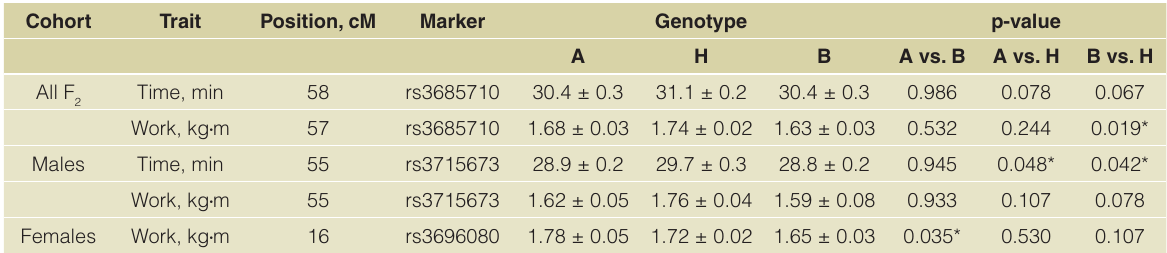
Table 3. Allelic effects for significant and suggestive QTL for exercise time and work in sex-specific and entire F